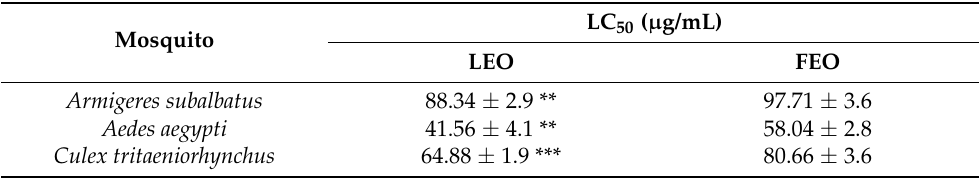
(** indicate p < 0.01; *** indicate p < 0.001)